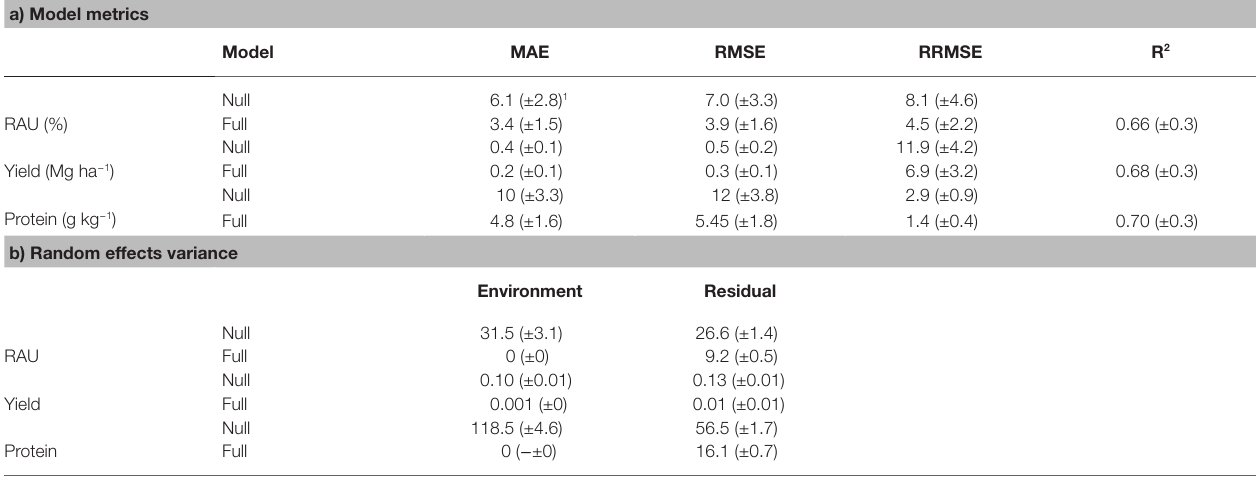
TABLE 2 | Full models precision and accuracy metrics for the RAU, yield, and protein